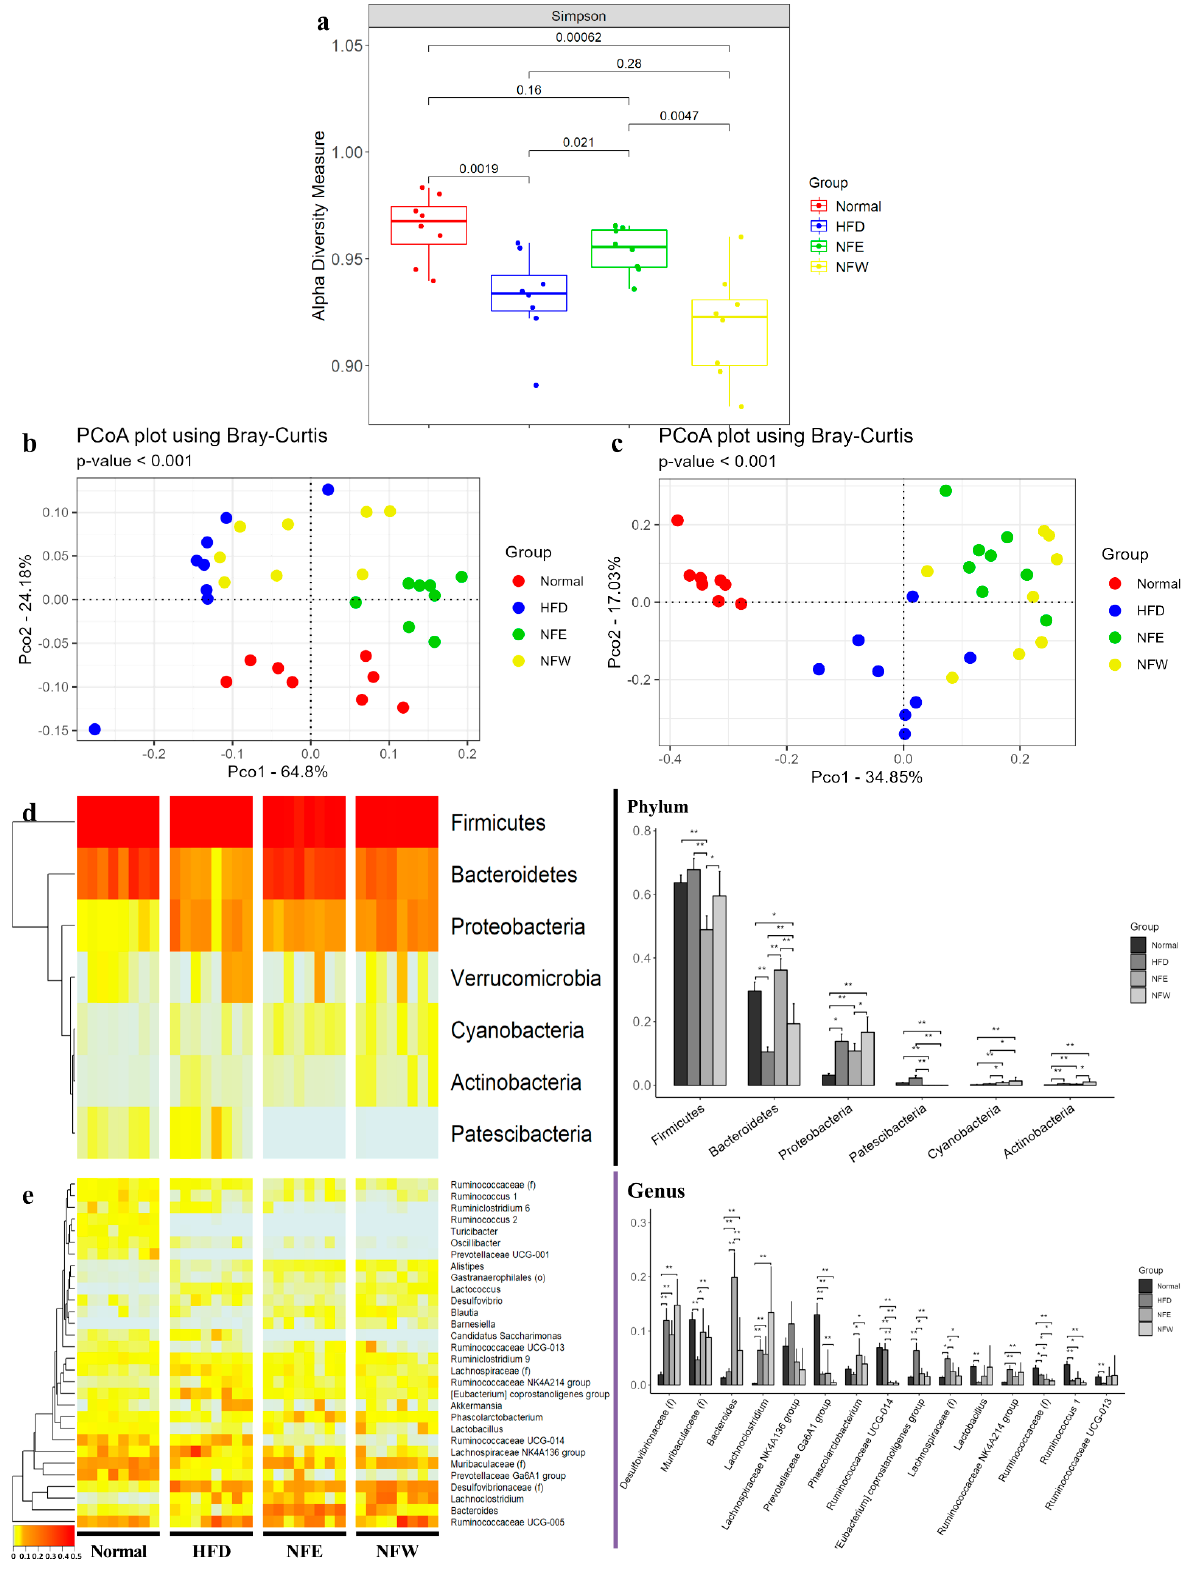
Figure 5. Alpha diversity, beta diversity, and compositions of microbiota at phylum and genus levels in rat stool samples. ( a ) Alpha diversity defined by observed OTUs, Chao1, and Shannon and